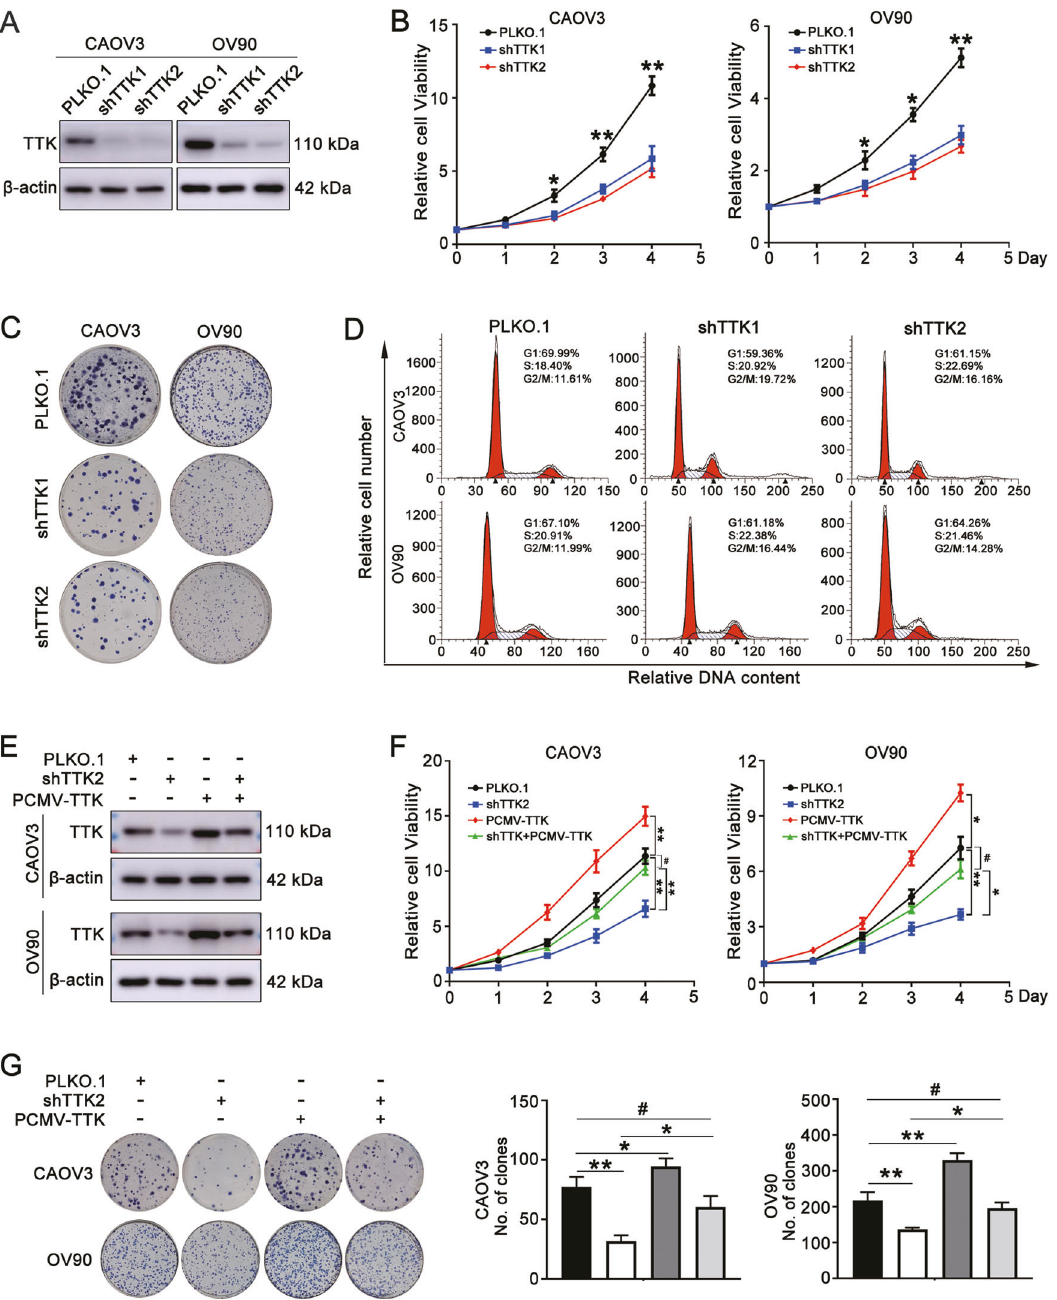
Fig. 2 TTK depletion inhibits ovarian cancer cell proliferation by disturbing cell cycle progression. CAOV3 and OV90 cells were stably transfected with PLKO.1 or the TTK shRNA (shTTK1 and shTTK2) A The TTK protein level in CAOV3 and OV90 cells after TTK knockdown. B MTT assays showed the effect of TTK knockdown on the proliferation of CAOV3 and OV90 cells. C The effect of TTK inhibition on the colony formation ability of CAOV3 and OV90 cells. D Cell cycle analysis of CAOV3 and OV90 cells after TTK knockdown. The TTK overexpression plasmid (PCMV-TTK) was transiently transfected into CAOV3 and OV90 cells stably transfected with shTTK2. E Western blot assay was used to assess the expression of the TTK protein 48 h after the transfection of the PCMV-TTK plasmid. F The effect of TTK overexpression on the proliferation of TTK-silenced CAOV3 and OV90 cells was detected using the MTT assay. G Colony formation assays were performed to assess the colony formation capacity when TTK was overexpressed in TTK knockdown ovarian cancer cells (data are mean ± SEM, # P > 0.05, * P < 0.05, ** P < 0.01, n = TTK and autophagy, although TTK has been reported to be replication and the cell cycle pathways (Supplementary Fig. involved in the PI3K/AKT or Akt/mTOR pathways, which S4B, C), consistent with previous studies, indicating that the regulate autophagy. Consequently, we speculated that TTK sequencing results were reliable. The autophagy pathway, one inhibition suppresses ovarian cancer cell proliferation and of the top fi ve pathways affected by TTK depletion, has been increases the sensitivity of ovarian cancer cells to cisplatin by shown to be involved in cisplatin resistance in ovarian cancer. inhibiting the autophagy pathway. Few studies have focused on the direct relationship between